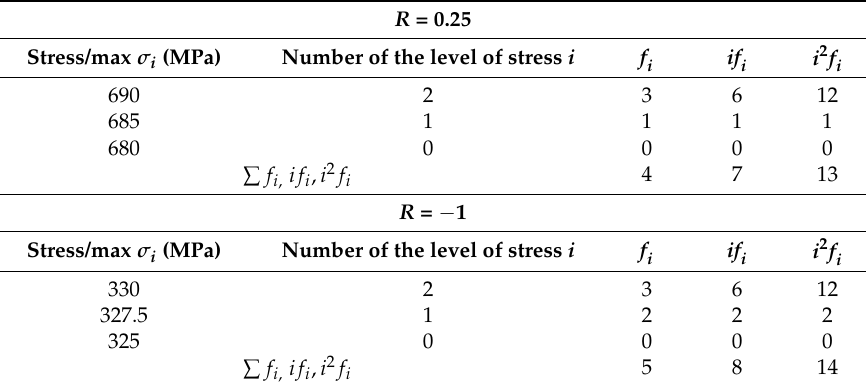
Table 5. Data analysis for the modified staircase method ( f = failed). R =